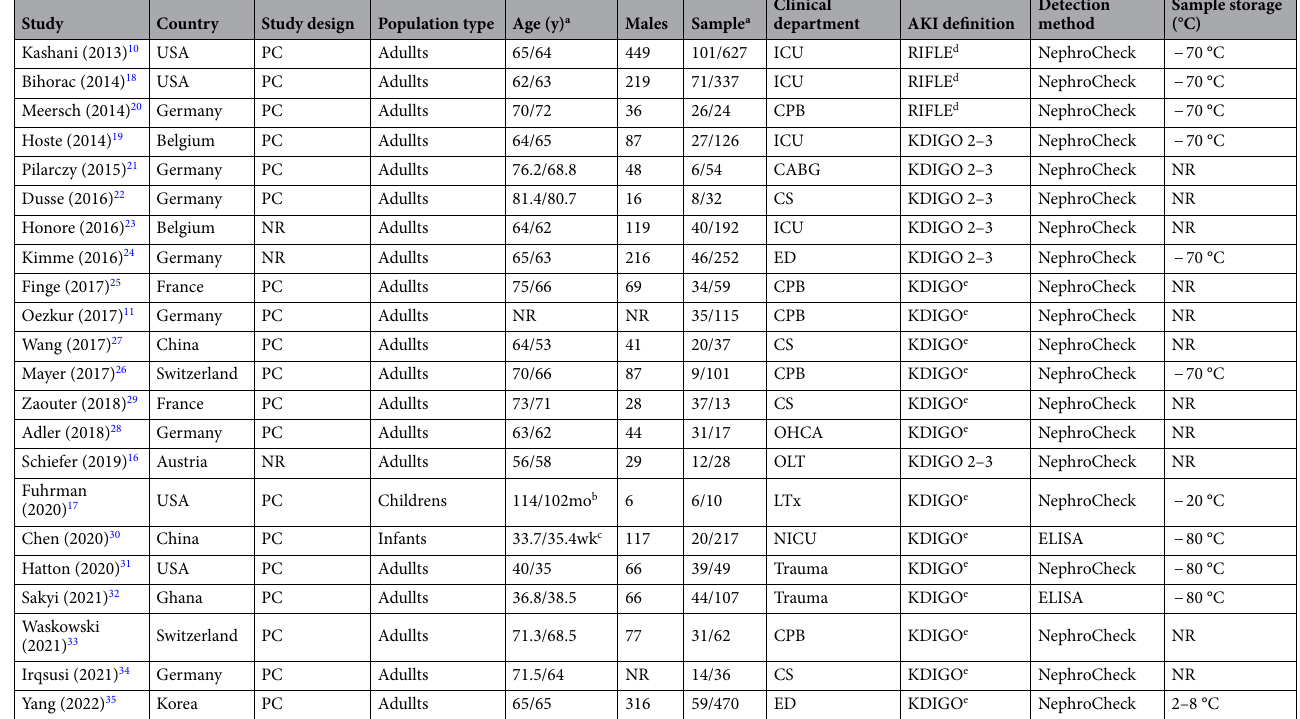
Table 1. Characteristics of Incloud studies. AKI acute kidney injury, CABG coronary artery bypass surgery, CPB cardiopulmonary bypass, CS cardiac surgery, ED emergency department, ICU intensive care unit, LTx liver transplant, NICU neonatal intensive care unit, NR not reported, OHCA out-of-hospital cardiac arrest, OLT orthotopic liver transplantation, PC prospective cohort. a A backslash separating 2 values denotes AKI/ no AKI; b month; c Gestational age; d RIFLE, risk, injury, failure, loss, end stage kidney disease; e KDIGO Kidney Disease: Improving Global